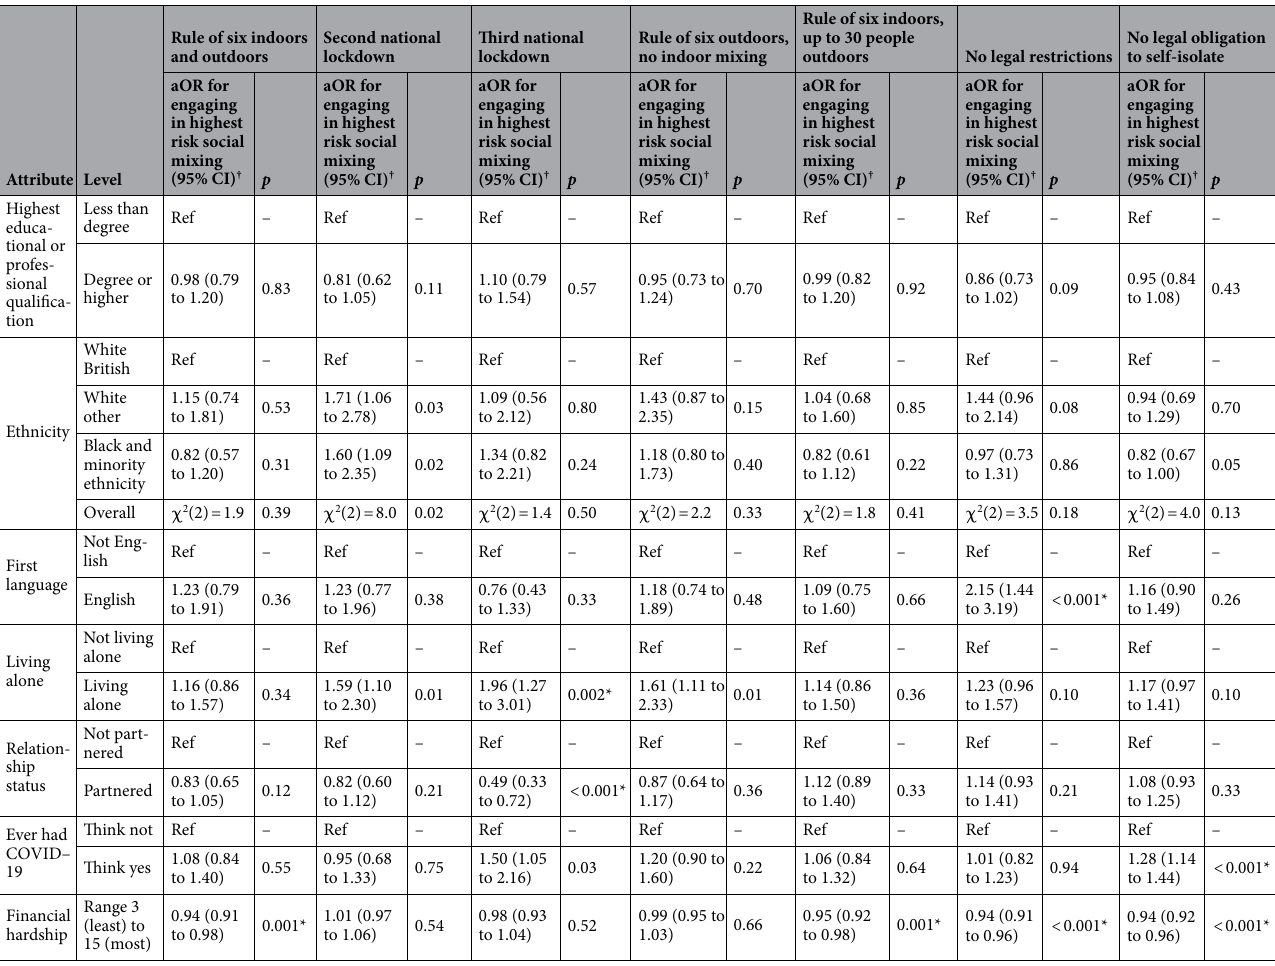
Table 5. Socio-demographic characteristics associated with engaging in highest risk social mixing at different time points in the pandemic. † Adjusting for wave, region, gender, age (raw and quadratic), presence of a dependent child in the household, having a chronic illness oneself, having a household member who has chronic illness, employment status, highest earner in household works in a manual occupation, index of multiple deprivation, highest educational or professional qualification, ethnicity, first language, living alone, relationship status, having had COVID-19 before, and financial hardship. * p ≤